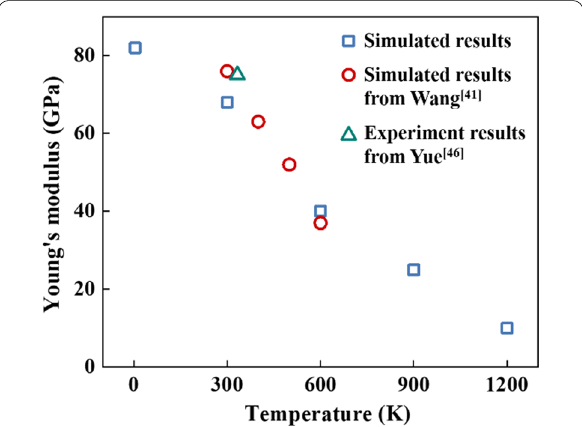
Fig. 3 Comparison of Young’s modulus